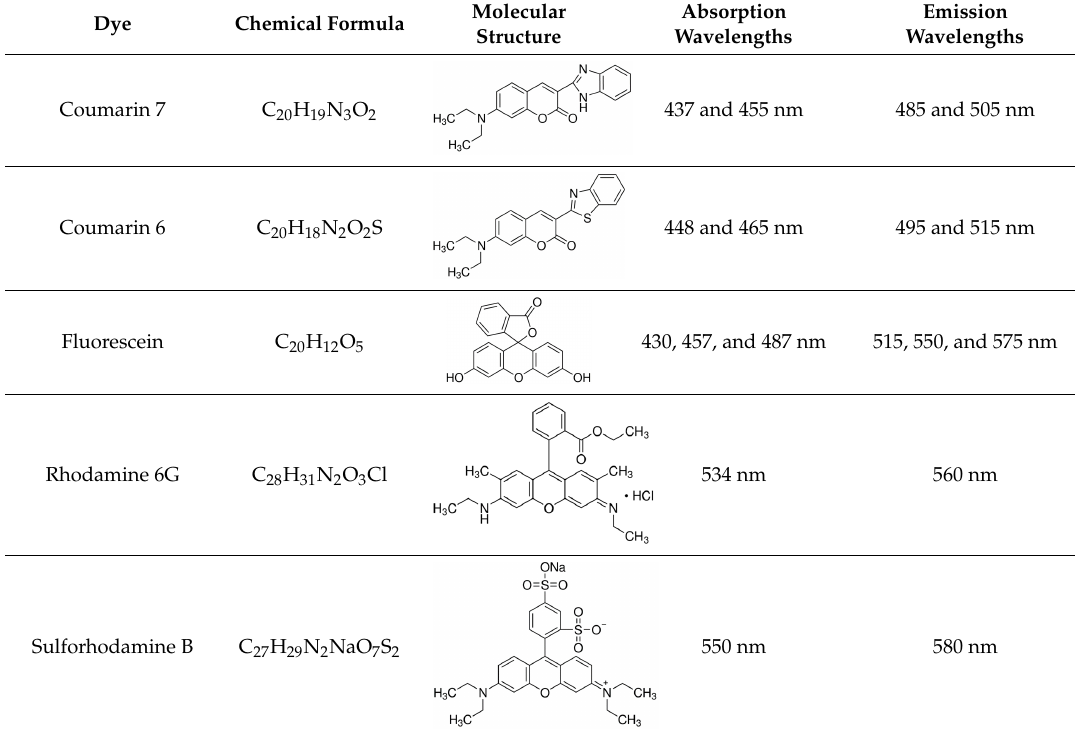
Table 1. Chemical formulas, molecular structures, and optical properties of the dyes used for doping the polymer solutions.